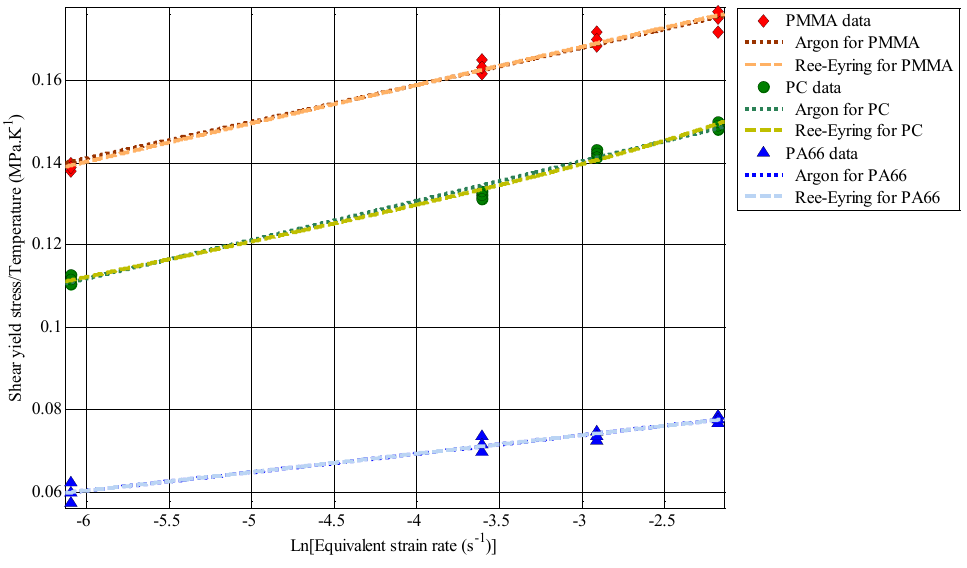
Figure 11. Best-fit evolution of the shear yield stress as a function of logarithm of equivalent strain rate [25].